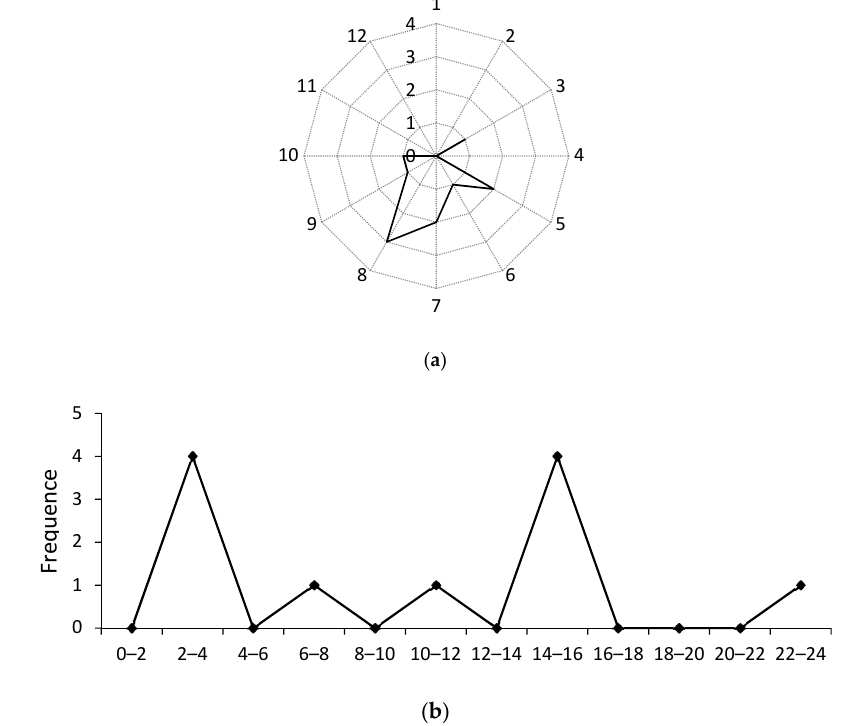
Figure 3. ( a ) Months. ( b ) Hours. Time-series analysis for commercial vehicle accidents.